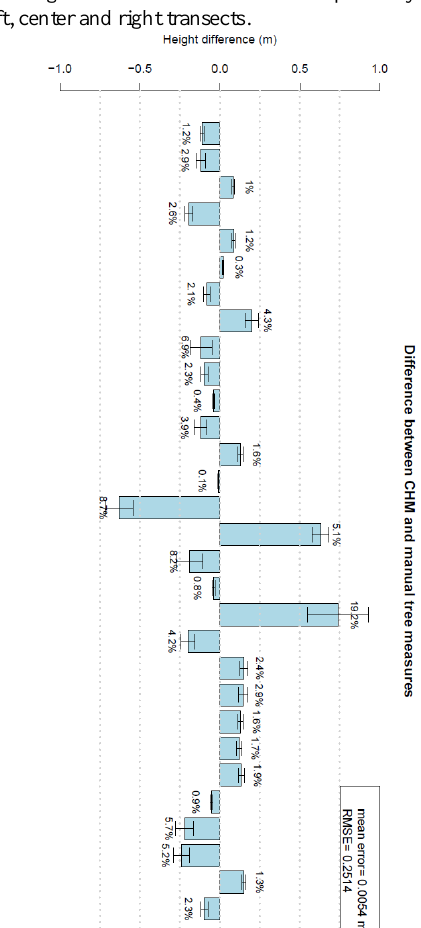
Figure 10. Result of height differences over 30